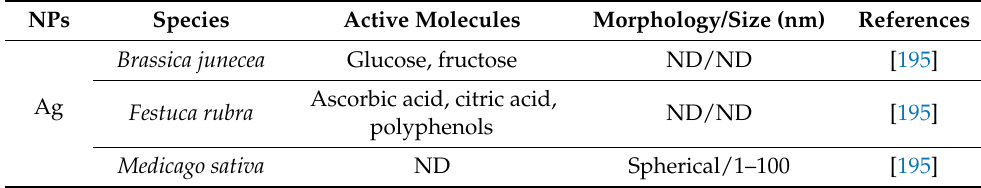
Table 6. Nanoparticles produced by live plants.